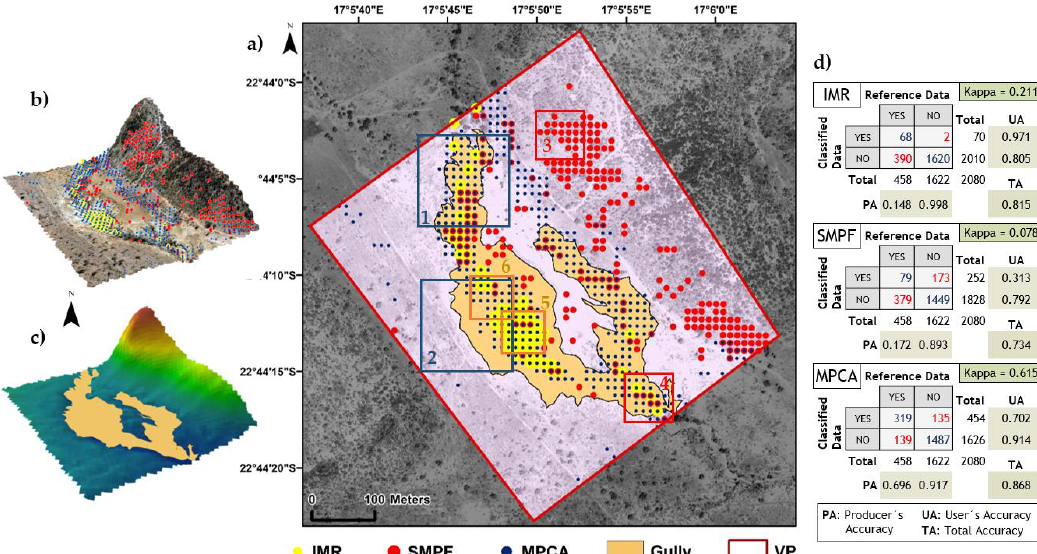
Figure 13. ( a ) Results of the different gully classification methods for VP4. The blue frames (1 and 2) represent the MPCA kernels studied in Figure 14. Red Squares (3 and 4) are those extents of the SMPF kernels studied in Figure 15 and yellow Squares (5 and 6) are those extents of the IMR kernels presented in Figure 16. ( b , c ) 3D scenes of gully extents and results of the classification. ( d ) Resultant Confusion Matrices for IMR, SMPF and MPCA, and their correspondent Kappa values.